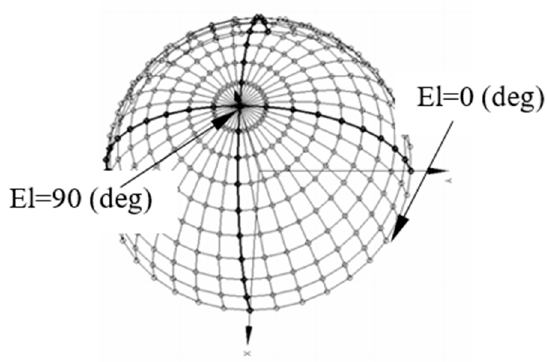
Figure 6. An example of defining the directions on the UV-sphere.